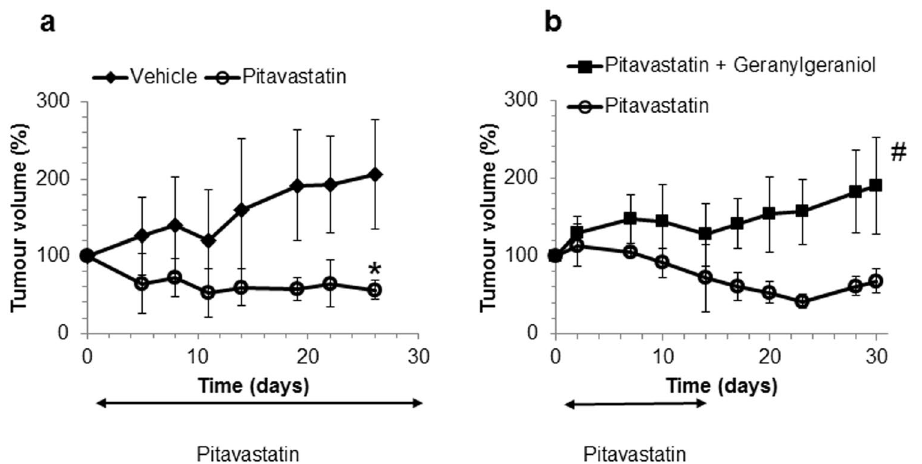
Figure 5. ( a ) Nude mice maintained on a diet of Ensure Plus and bearing subcutaneous Ovcar-4 tumours (mean volume 150 mm 3 , 6 animals per study arm) were treated twice daily with vehicle or pitavastatin-calcium (59 mg/kg, p.o.). After 28 days, tumour volume was significantly different in the mice receiving pitavastatin ( * P < 0.005, t -test with Welch’s correction). Animal body weight increased throughout the course of the dosing period and no significant adverse events were observed. ( b ) Nude mice bearing subcutaneous Ovcar-4 tumours (mean volume 220 mm 3 , 4 animals per study arm) were treated twice daily with pitavastatin-calcium (59 mg/ kg, p.o.) for days 1–14 while being provided a diet of either Ensure Plus or Ensure Plus supplemented with 0.14 mg/mL geranylgeraniol. Animal body weight increased throughout the course of the dosing period and no significant adverse events were observed. Mice were returned to regular chow on day 16. After 28 days, tumour volume was significantly larger in the animals receiving dietary geranylgeraniol ( # P < 0.05, t -test with Welch’s